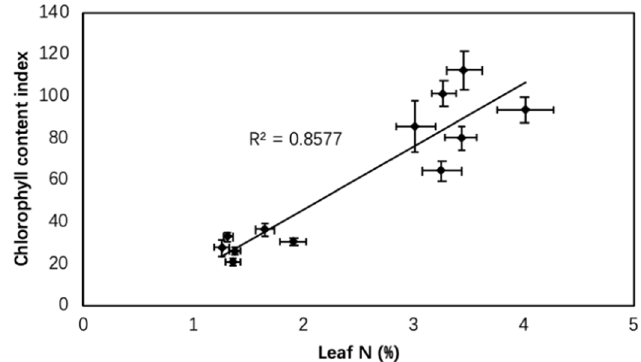
Figure 6. Relationship between chlorophyll content index (CCI) and leaf N content as affected by biochar, irrigation regimes, and salinity.